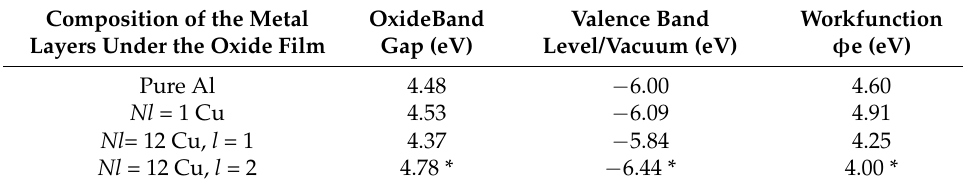
Table 1. Summary of the calculated properties of the different models of passive film on Al and AlCu alloy considered in this work: Pure aluminium, a single copper at the oxide/metal interface, a copper monolayer in l = 1, a copper monolayer in l = 2.